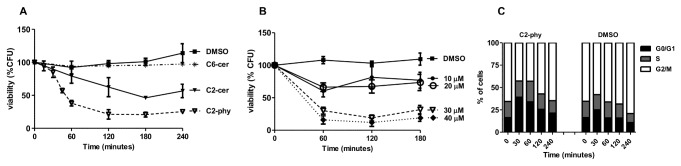

S. cerevisiae cells are sensitive to ceramides.(A) Survival of W303-1A cells exposed to 30 µM C2-phytoceramide (∇), 30 µM C6-ceramide (*), 30 µM C2-ceramide (▼), or equivalent volume of solvent (■). CFU values of C2-treated cells significantly different from DMSO-treated cells, P<0.0001, Two-Way ANOVA. (B) Survival of W303-1A cells exposed to 10 µM (●), 20 µM (○), 30 µM (∇-dashed lines) and 40 µM (♦-dashed lines) C2-phytoceramide, or equivalent volume of solvent (■). CFU values of C2-phytoceramide-treated cells (30 µM or 40 µM) are significantly different from DMSO-treated cells for all time points, P<0.001, Two-Way ANOVA. All CFU values (A and B) represent mean ± SE of at least 3 independent experiments, with 5 replicas in each experiment. (C) Cell cycle progression of cells exposed to 30 µM C2-phytoceramide or equivalent volume of solvent. Data from a representative experiment (of 3 independent experiments) is shown.